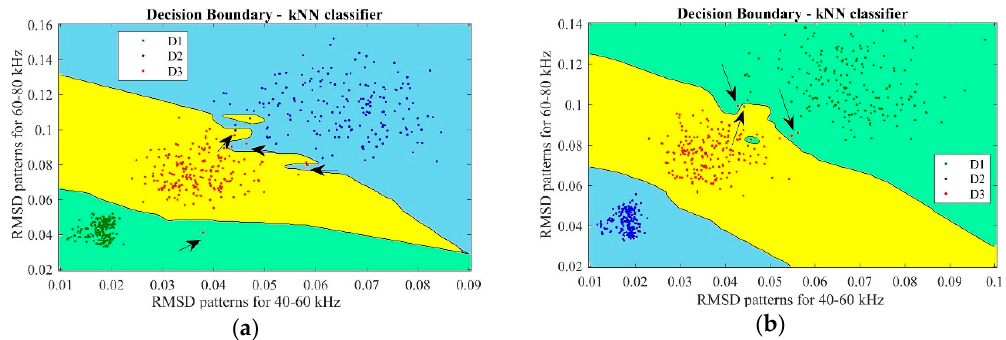
Figure 5. Confusion matrices of the best ANN models in experimental case #1: ( a ) model#1 ; and ( b ) model#3 .